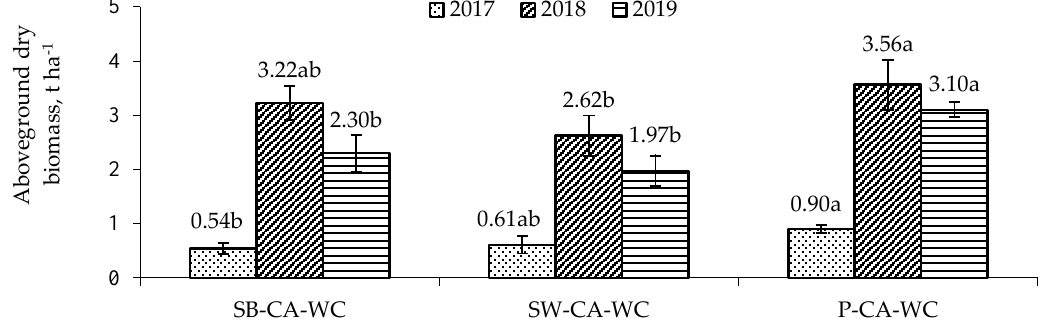
Figure 8. Aboveground dry biomass of white clover in trinary crops in 2017–2019. Note. CA—caraway, SB—spring barley, SW—spring wheat, P—pea, WC—white clover. Differences between the averages of treatments per one experimental year separately (2017–2019) marked with different letters (a, b), are significant ( p < 0.05); error bars indicate the standard error.